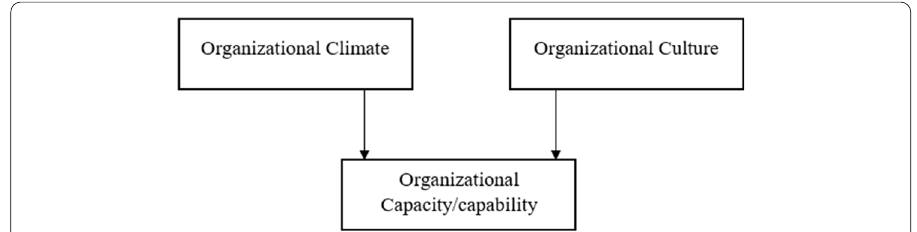
Fig. 1 Framework of modified organizational development theory [45]